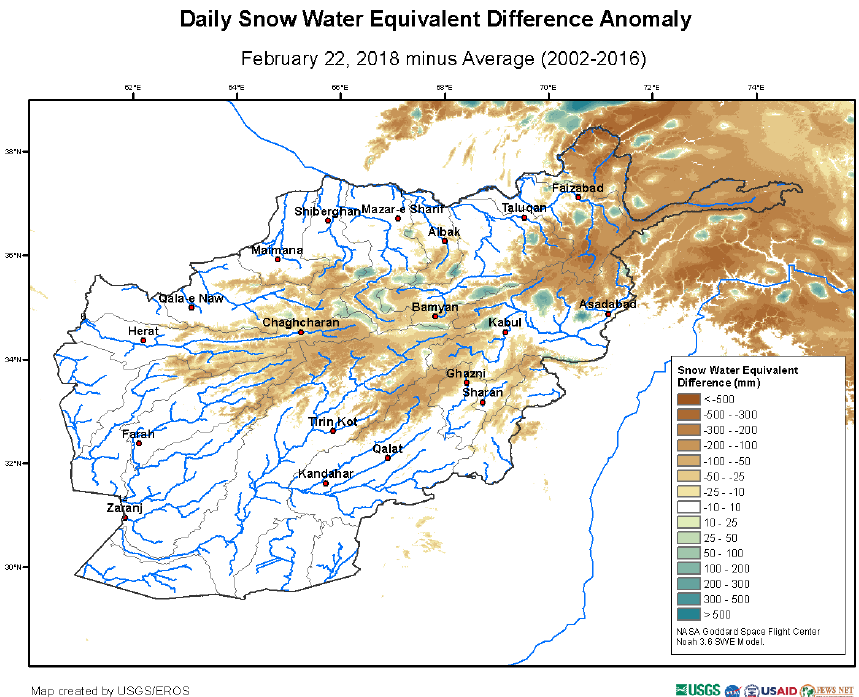
Figure 9. FLDAS Central Asia snow water equivalent (SWE) estimates for 22 February 2018. SWE deficits of 300mm were widespread at this